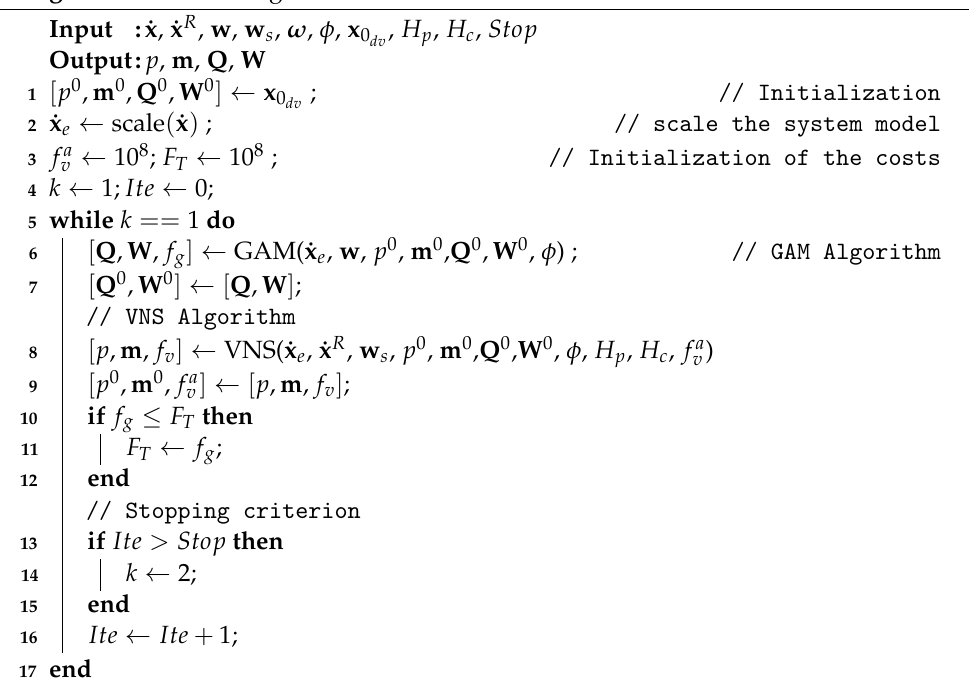
Algorithm 2: MPCT